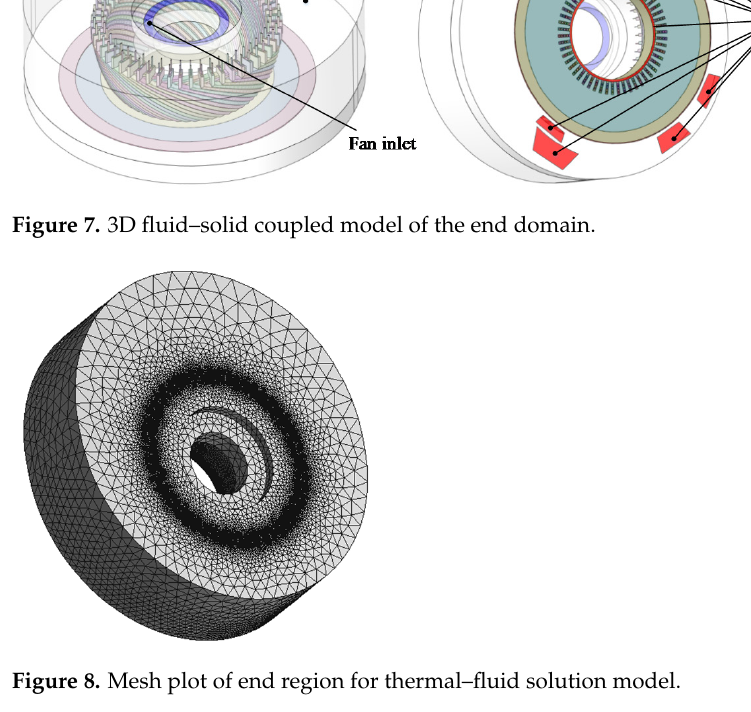
Figure 8. Mesh plot of end region for thermal–fluid solution model.